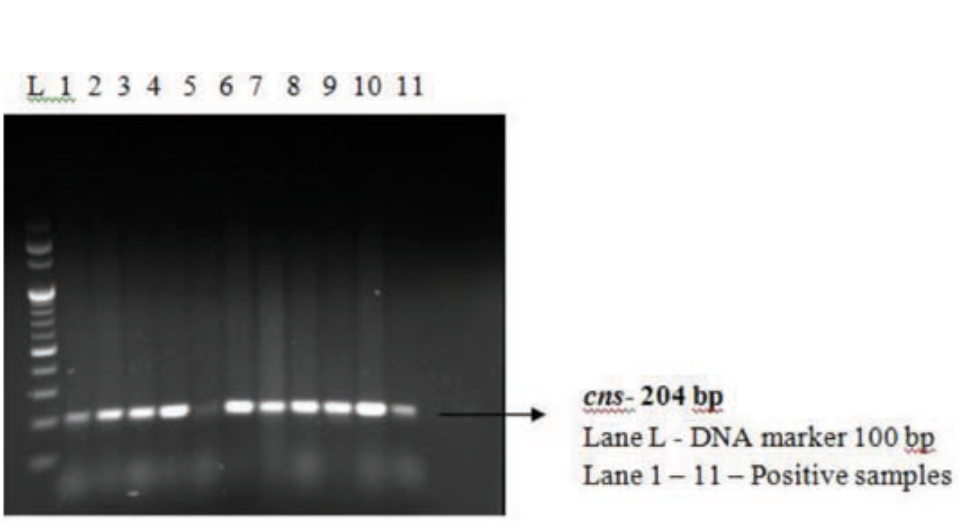
Fig. 2 . PCR for detection of Staphylococcus